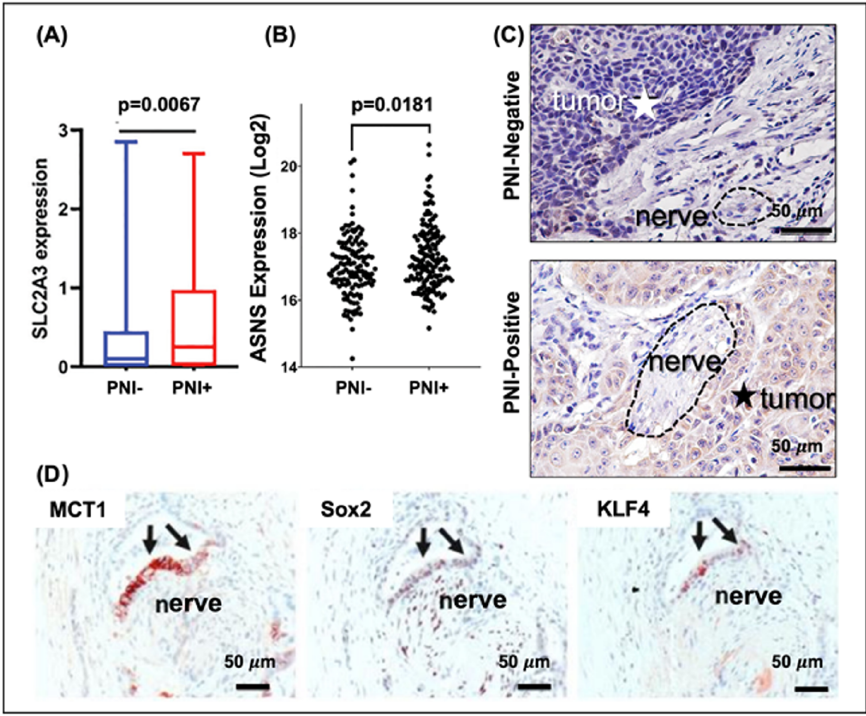
Figure 2. Metabolism-related cancer–nerve crosstalk. ( A ) Vitamin C transporter SLC2A3 is shown via immunohistochemistry to be upregulated in colorectal cancer patients with perineural invasion (PNI) [206]. mRNA ( B ) and immunohistochemistry ( C ) analyses found that asparagine synthetase (ASNS) is upregulated in PNI-positive oral squamous-cell carcinoma patients. Dotted circles represent nerve trunks, and stars indicate the tumor region [28]. ( D ) Lactate importer MCT1 is colocalized with Sox2- and KLF-positive (cell-proliferation markers) in cases of PNI in pancreatic adenocarcinoma [205]. Scale is 50 µ m. Figures are modified from Gao et al., Fu et al., and Sandforth et al., respectively.